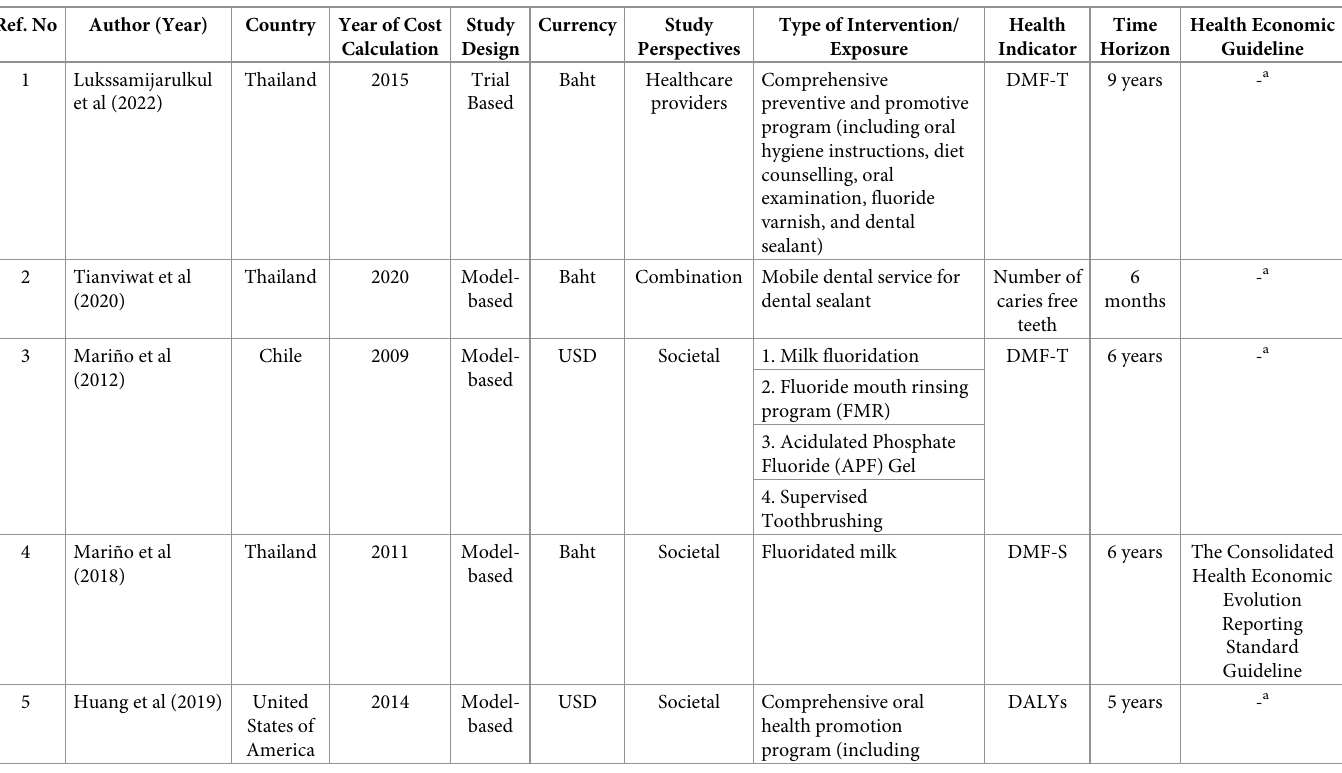
Table 2. Characteristic of the included